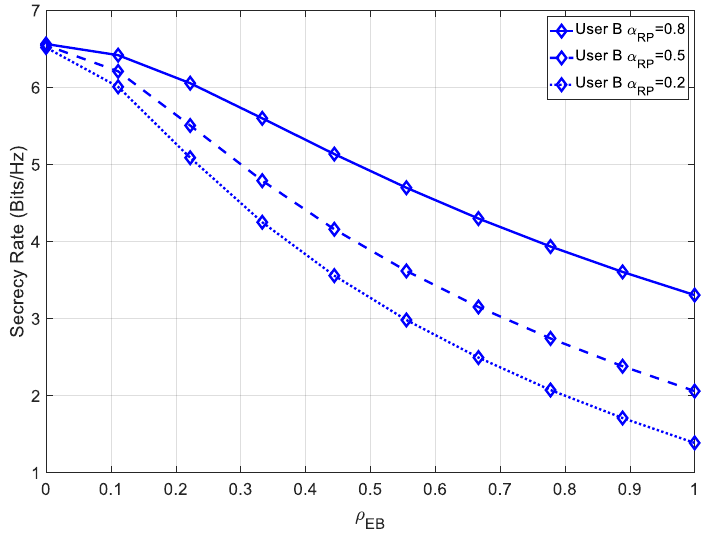
Figure 8. Secrecy rate of the 8 × 8 LOS receiver B with perfect channel estimation and varying ray power coefficient.